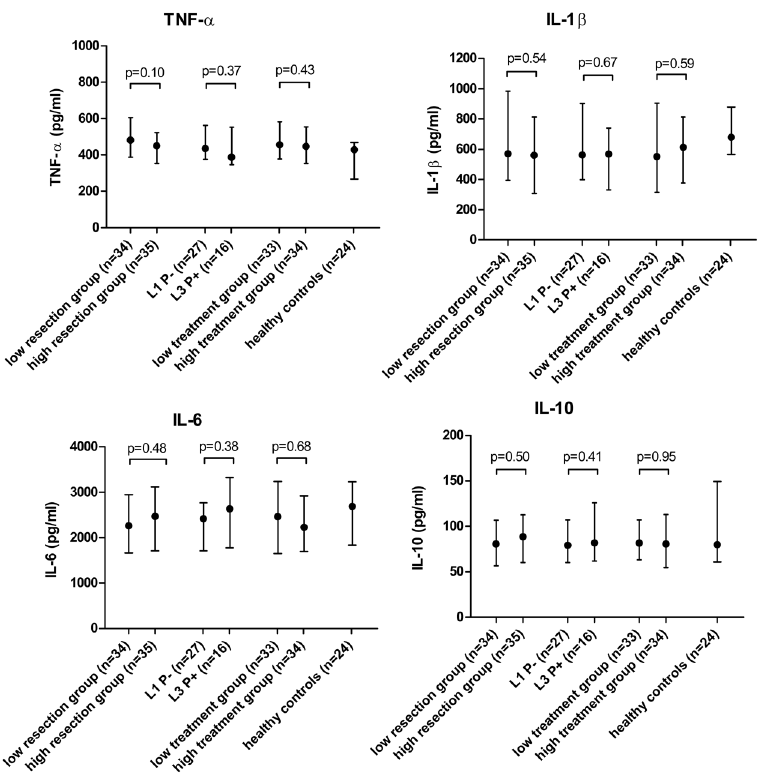
Fig 1. Relation between cytokine production and disease severity. Values are presented as medians (pg/ml) with the interquartile range. For the number of bowel resections and treatment exposure patients were dichotomized in a low and high group according to the number of resections or the percentage of years in which they were treated with steroids, thiopurines, biologicals, methotrexate or cyclosporine, corrected for disease duration. Two patients were excluded for the analysis for treatment exposure, because no complete drug history was available. TNF- α , Tumor necrosis factor alpha; IL, Interleukin; L1, ileal disease; L3, ileocolonic disease; P-, no fistulas; P+, fistulating